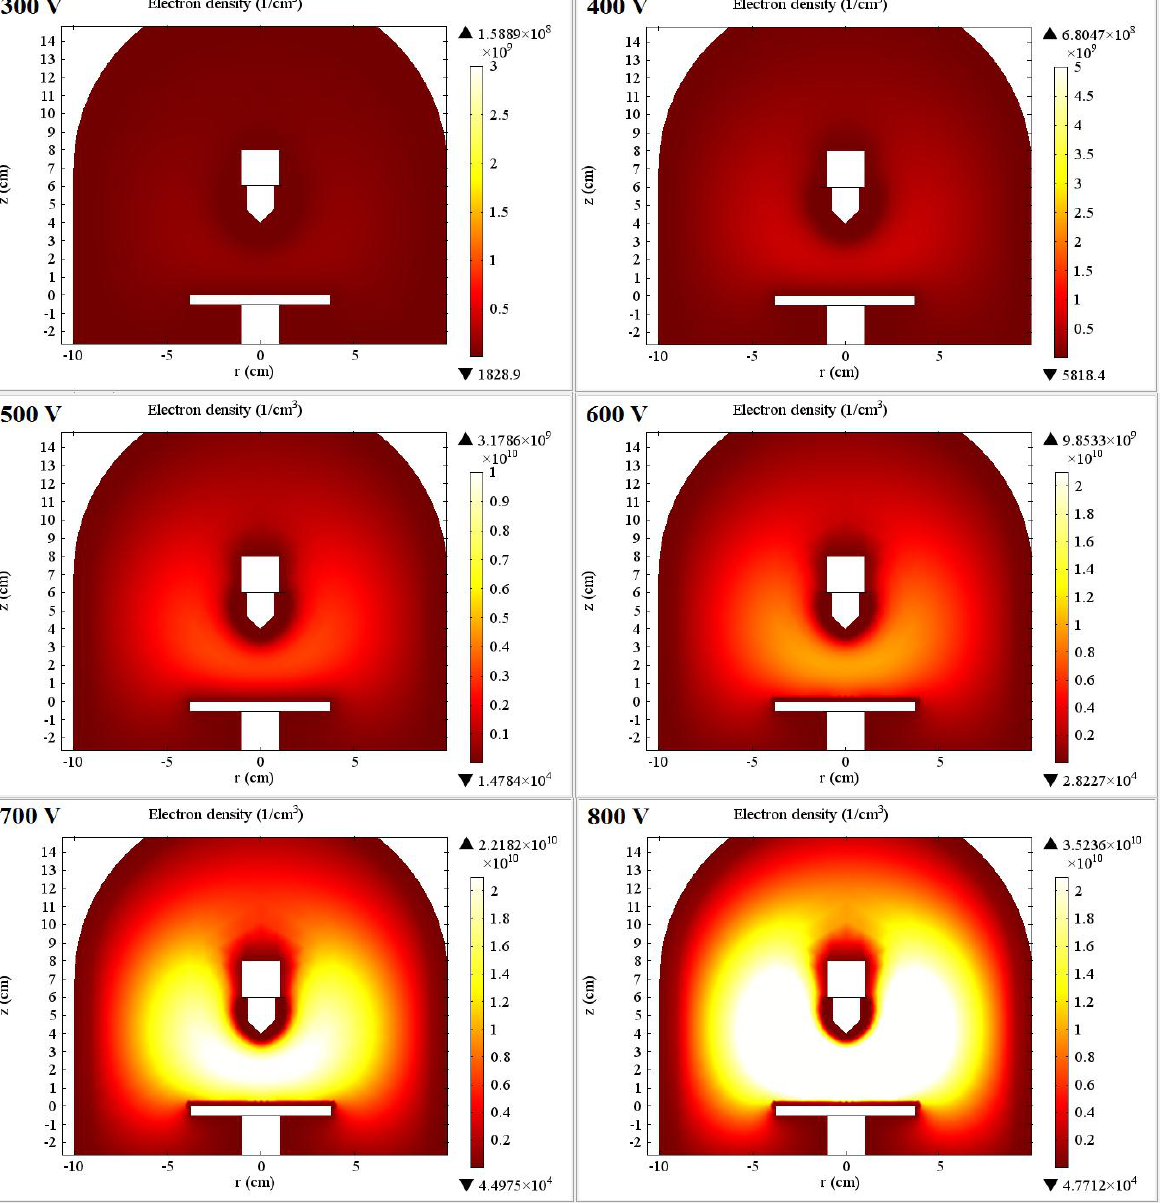
Fig. 5: The distribution of electron density with different applied